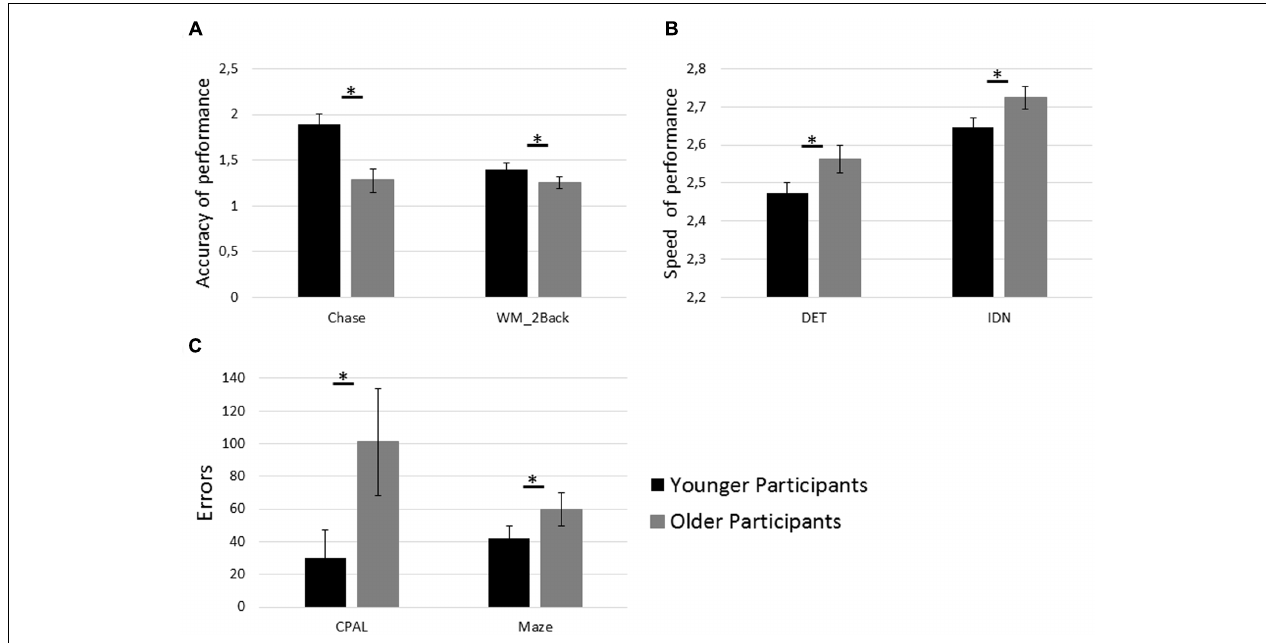
FIGURE 3 | Age group differences in cognitive test performance. (A) Performance in the tests assessing speed of visual processing (Chase) and working memory capacity (WM_2Back). (B) Performance in the tests assessing psychomotor function (DET) and attention (IDN). (C) Performance in the tests assessing paired associate learning (CPAL) and executive function (Maze). Asterisks ( ∗ ) indicate p < 0.05 and error bars indicate 95% confidence intervals. Interpretation and calculation of performance measures are described in Table 1